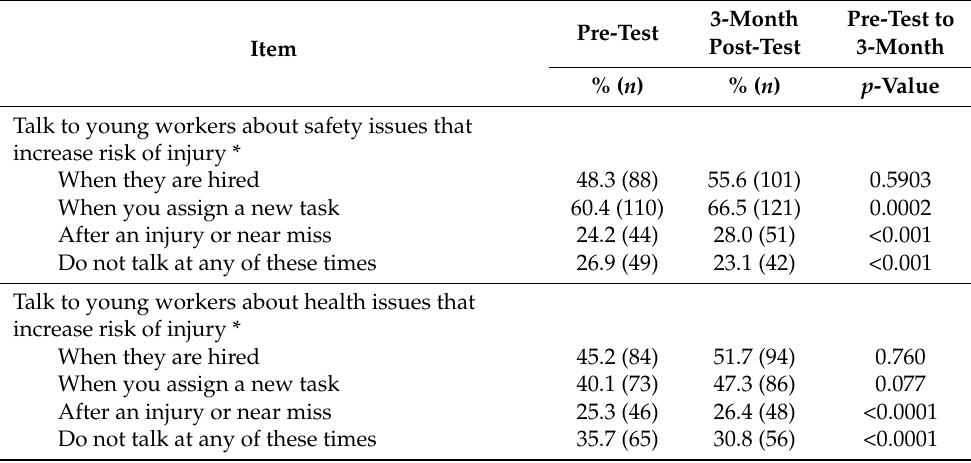
Table 6. Changes in supervisors’ frequency of whether they talk to young workers about safety and health issues (yes/no) that impact their risk of injury ( n = 182).